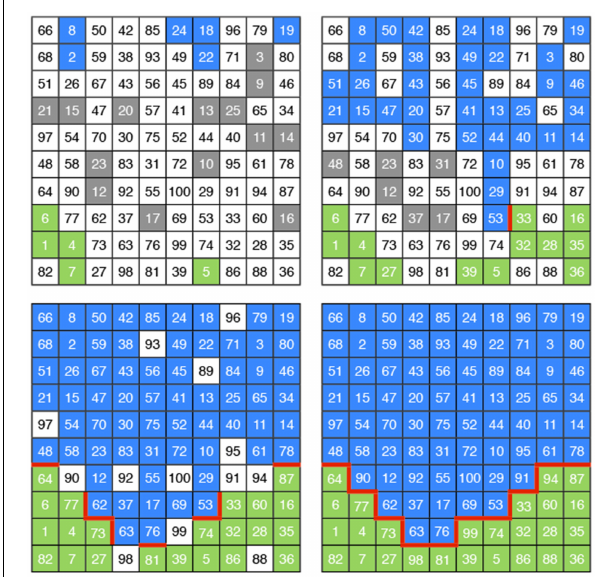
FIGURE 4 | Algorithm based on Invasion Percolation. As in Figure 3 , two sinks are considered: the top and the bottom rows. One starts from the bottom-right corner (cell 36). Since this site is in the bottom row, it is already part of the bottom sink (green). Proceeding upwards, following the most right column, the next unexplored cell is considered (cell 35). The basin to which this cell belongs grows by adding the smallest-height cell on its perimeter, until one sink is reached (cells 16, 28, 32, and 33 in the upper-left panel, reaching 36). Proceeding further to the top, the cell 87 is added to the (green) basin (connecting to 16). When the cell 78 is considered and the corresponding basin grown, a new (blue) basin is found draining toward the upper sink (upper-right panel). The cell-edge between cell 87 and 78 is considered part of the watershed (red-thick edge). Proceeding by iteratively identifying the basin of the cells in the neighborhood of the watershed edges, the full watershed is identified (bottom panels). Since the same initial ranked surface is considered, the final watershed is equal to the one obtained in Figure 3